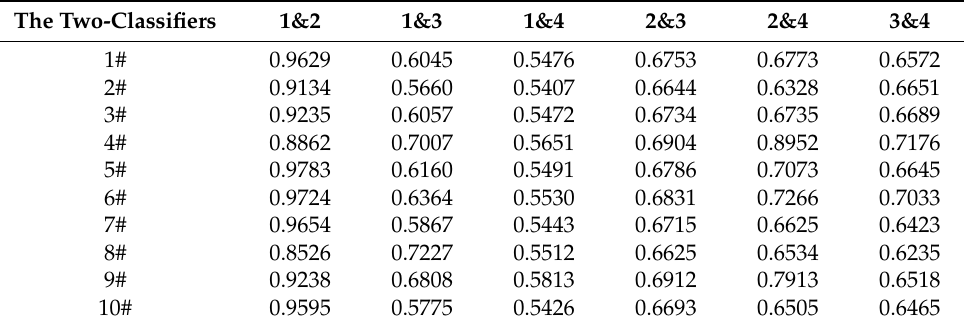
Table 3. The posteriori probabilities of 10 test sample groups in short-circuit